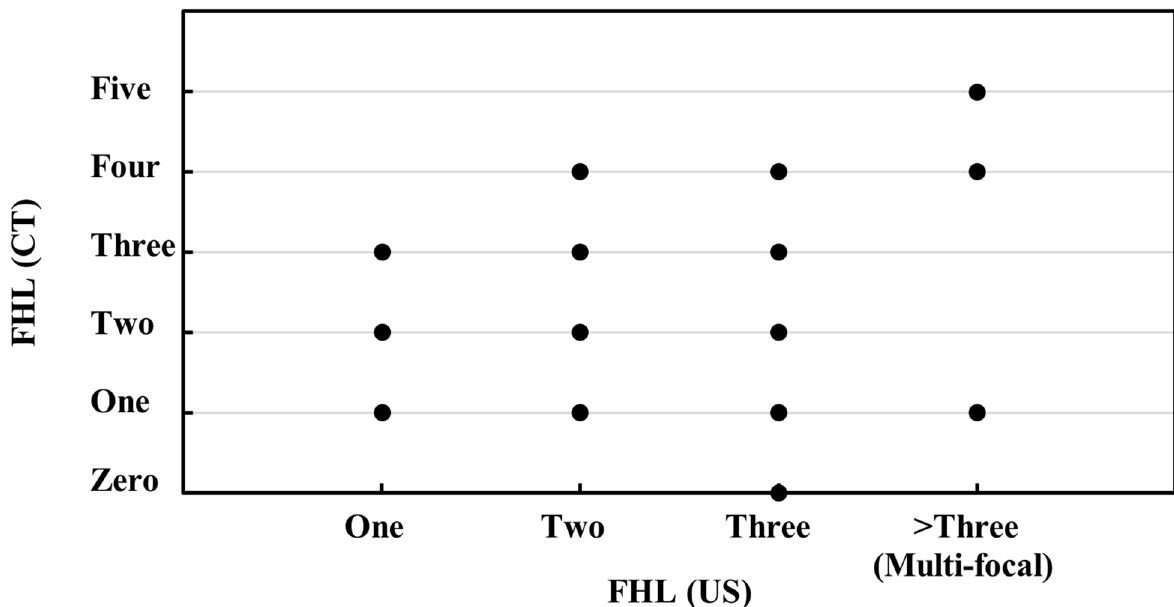
Fig. 6 Correlation between number of hepatic focal lesions by US and CT Fig. 6 There was statistically significant positive correlation between number of FHL by US and by CT scan (Spearman’s correlation coefficient